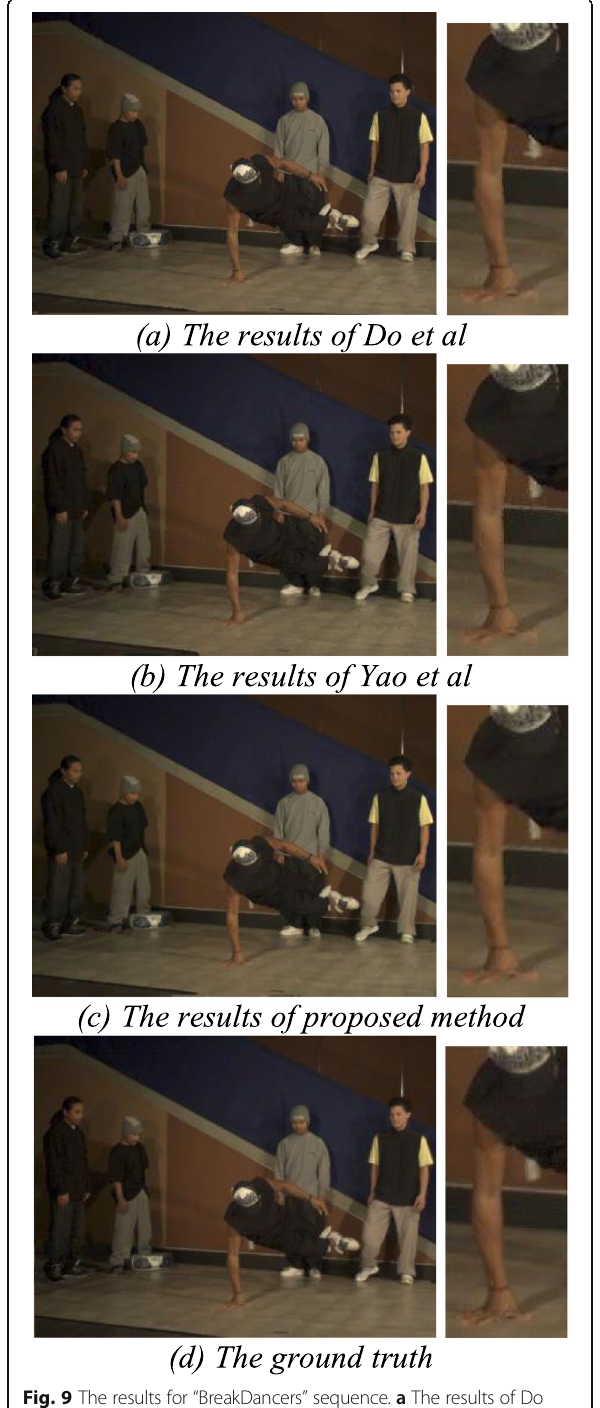
Fig. 9 The results for “ BreakDancers ” sequence. a The results of Do et al. b The results of Yao et al. c The results of proposed method. d The ground truth. Since the color of BreakDancers sequence is darker, it may be hard to see the difference between results of different methods. But when comparing with the ground truth image, we can see that the white square and the white line behind the dancer ’ s arm in proposed method are the result closest to the ground